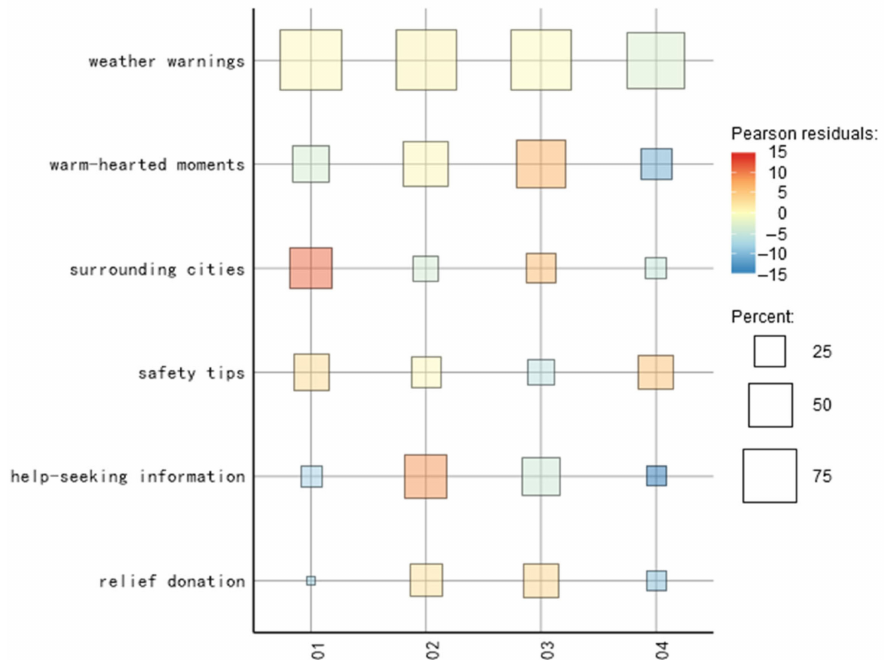
Figure 7. Bubble chart distribution of public opinion information transmission